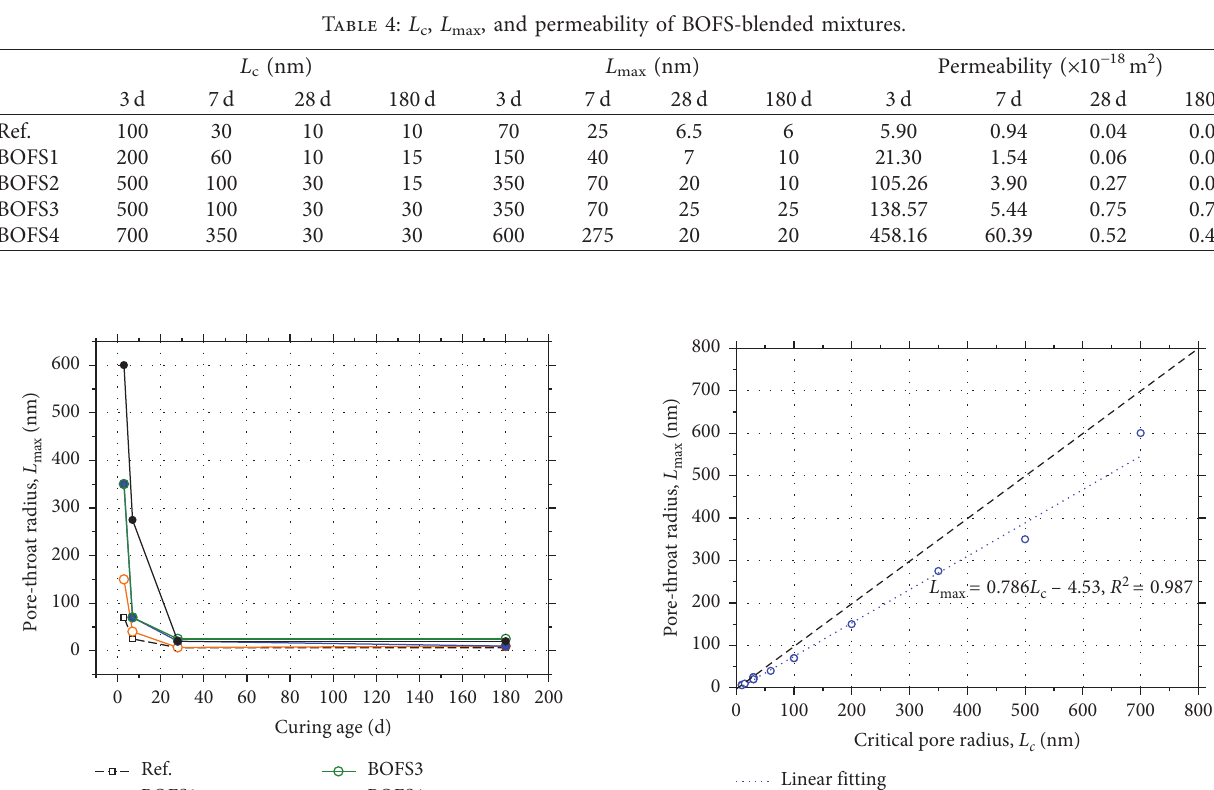
Figure 8: Linear relationship between L